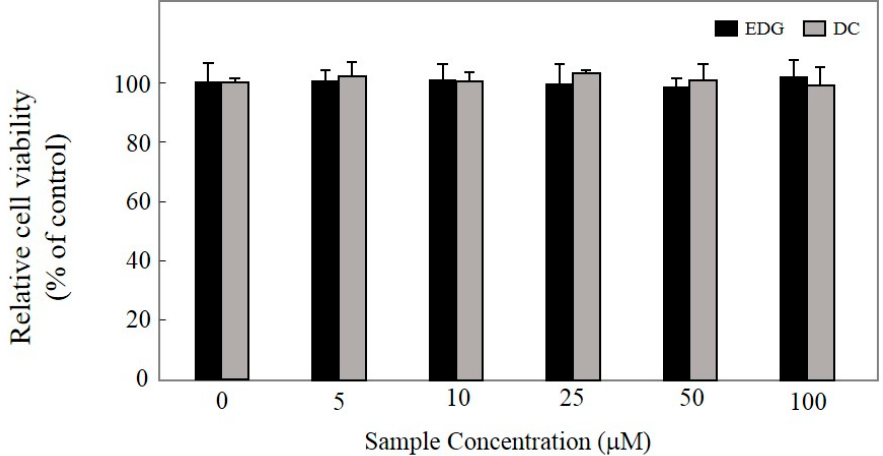
Figure 2. Cytotoxicity of EDG and DC. KU812F cells cultured in presence of di ff erent concentrations of EDG and DC for 24 h under serumfree conditions, and cell viabilities were determined via 3-(4,5-dimethylthiazol-2-yl)-5-(3-carboxymethoxyphenyl)-2-(4-sulfophenyl)-2 H -tetrazolium (MTS) assay. Each determination as made in triplicate, and data expressed as mean ± SD.